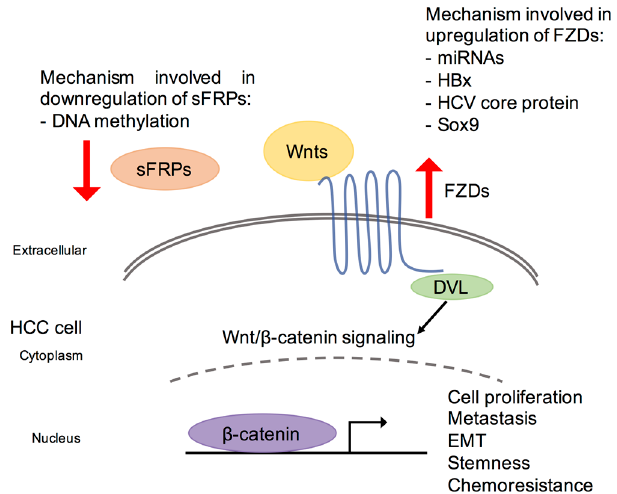
Figure 1. Schematic diagram of deregulated frizzled (FZD) receptors in the Wnt/ β -catenin signaling pathway in hepatocellular carcinoma (HCC). Wnt/ β -catenin signaling pathway is frequently activated in HCC. In terms of deregulated activation of FZD receptors, the underlying mechanism includes downregulation of sFRP1/2/5 as a result of DNA hypermethylation detected in HCC and upregulation of FZD receptors as a consequence of miRNA regulation, hepatitis B X protein (HBx) and hepatitis C virus (HCV) core protein involvement and overexpression of transcription factor Sox9. DVL, dishevelled; EMT, epithelial-to-mesenchymal transition; FZD, frizzled; HBx, hepatitis B X protein; sFRPs, secreted frizzled-related proteins.